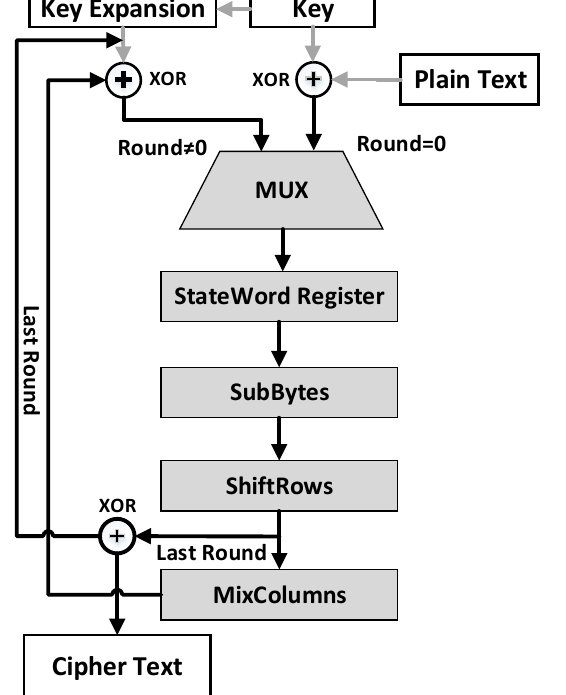
Figure 1. Structure of the AES